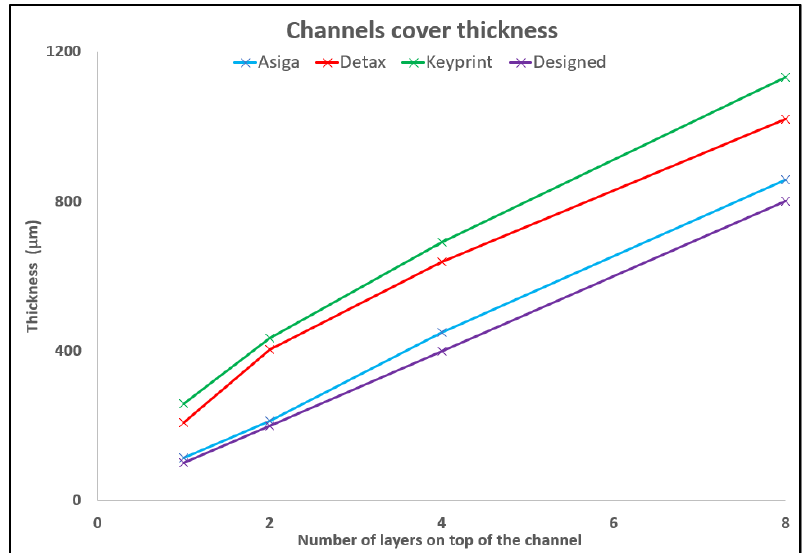
Figure 11. This graphic shows the thickness of the cover of every channel printed with the Asiga, Detax, and Keyprint resins vs. the design file values for one, two, four, and eight layers, respectively. The designed cover had a nominal thickness of 100 µm, 200 µm, 400 µm, and 800